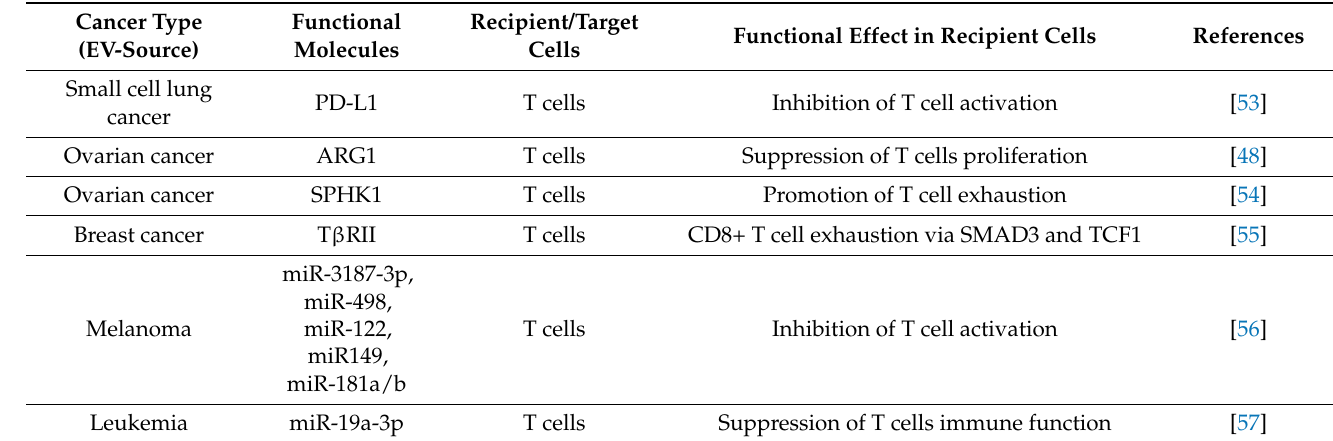
Table 1. TEV-mediated tumor immune